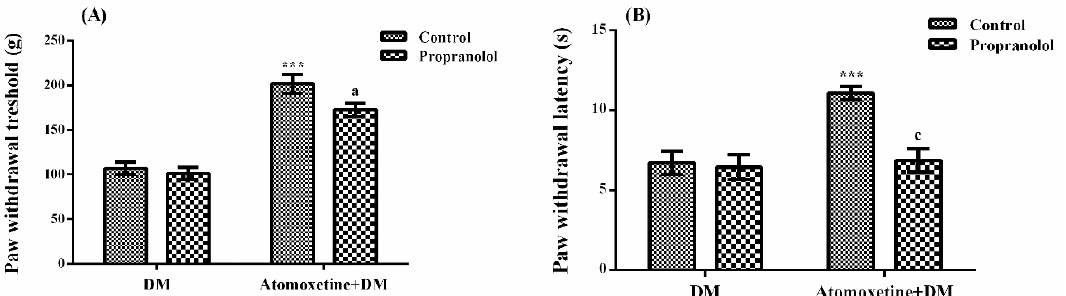
Figure 5. Effects of propranolol pre-treatments on the antihyperalgesic responses induced by atomoxetine (3 mg/kg, 14 days) against mechanical ( A ) and thermal ( B ) nociceptive stimuli applied in the Randall-Selitto and Hargreaves tests, respectively. Values are given as mean ± S.E.M. Significant difference against physiological saline administrated diabetic group (DM) is *** p < 0.001; Significant difference against atomoxetine administrated diabetic groups (Atomoxetine + DM) are a p < 0.05 and c p < 0.001. Two-way repeated ANOVA, post hoc Bonferroni test, n = 8.